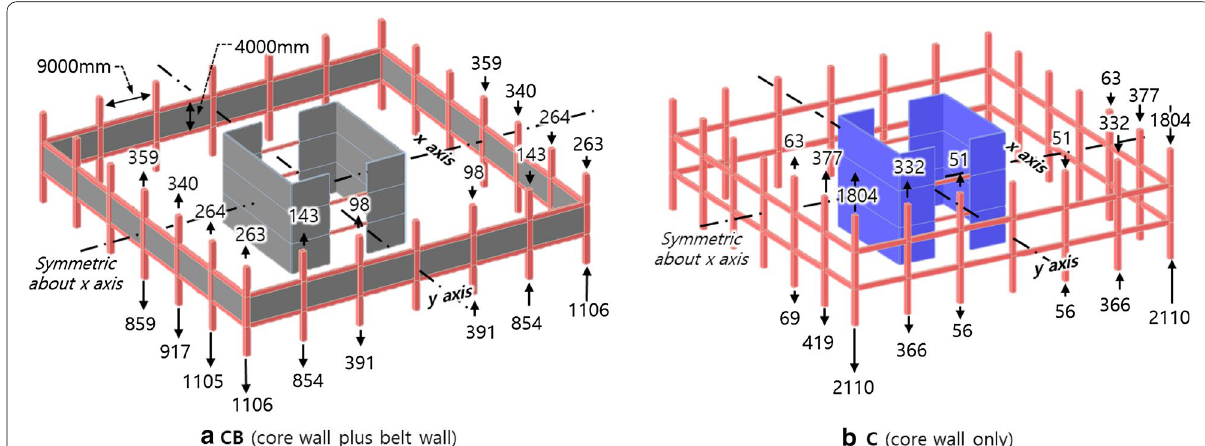
Fig. 5 Distribution of column axial forces above and beneath the 15th floor belt walls.